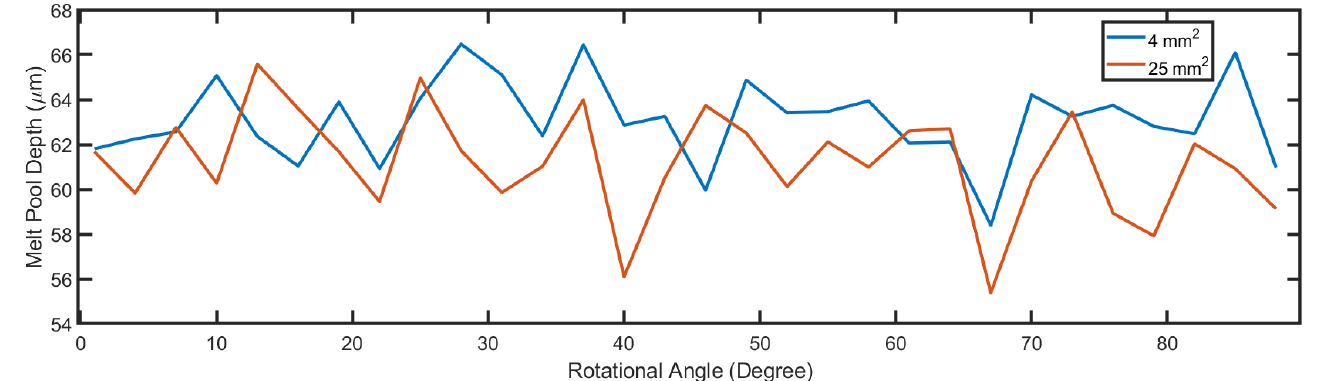
Figure 13. The predicted melt pool depth evolution with continuous scan time.